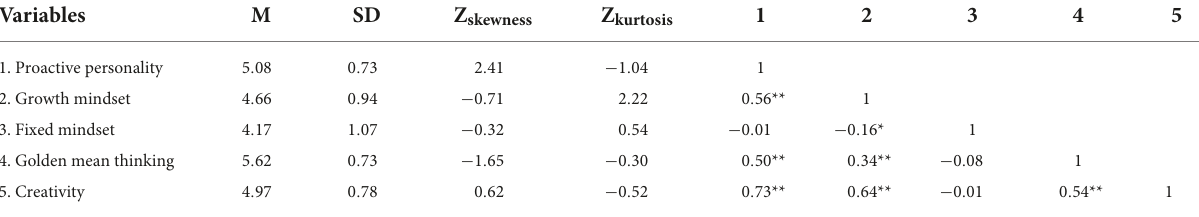
TABLE 1 Means, standard derivations, skewness, kurtosis, correlations of the study variables. Variables M SD Z